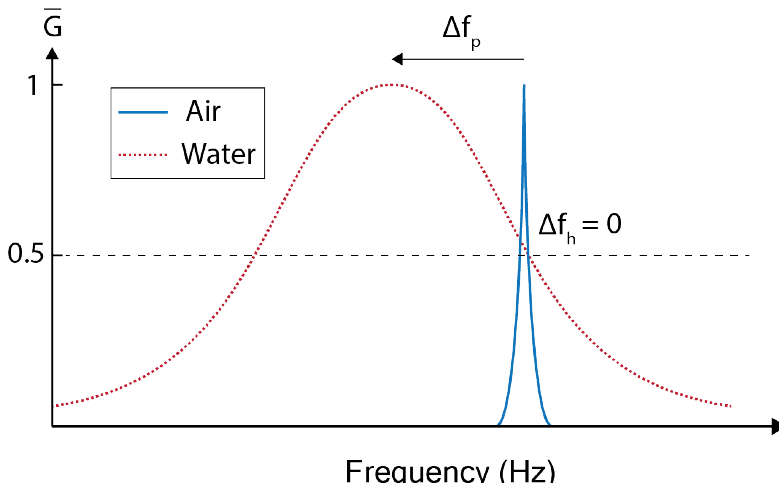
Figure 30. The simulation of normalized conductance curve of QCM in contact with air and water. The frequency at half maximum point does not change under viscous